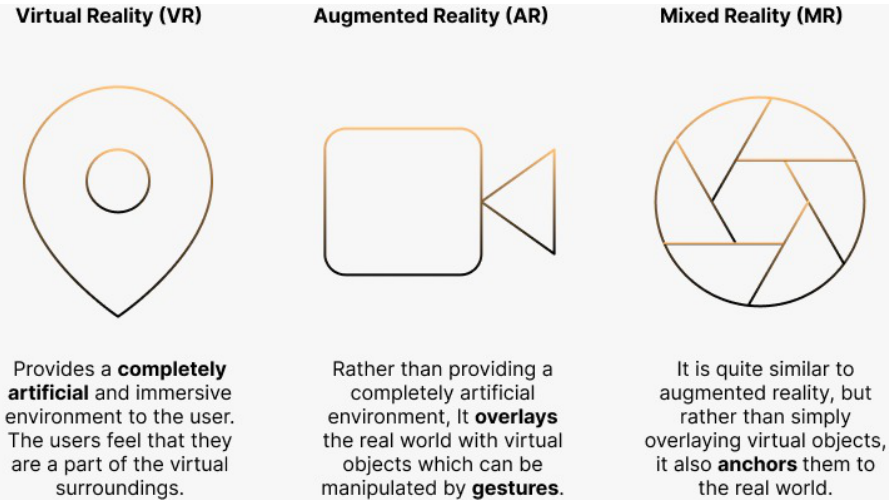
Figure 1. A quick and concise comparison of the various types of artificial reality paradigms currently in